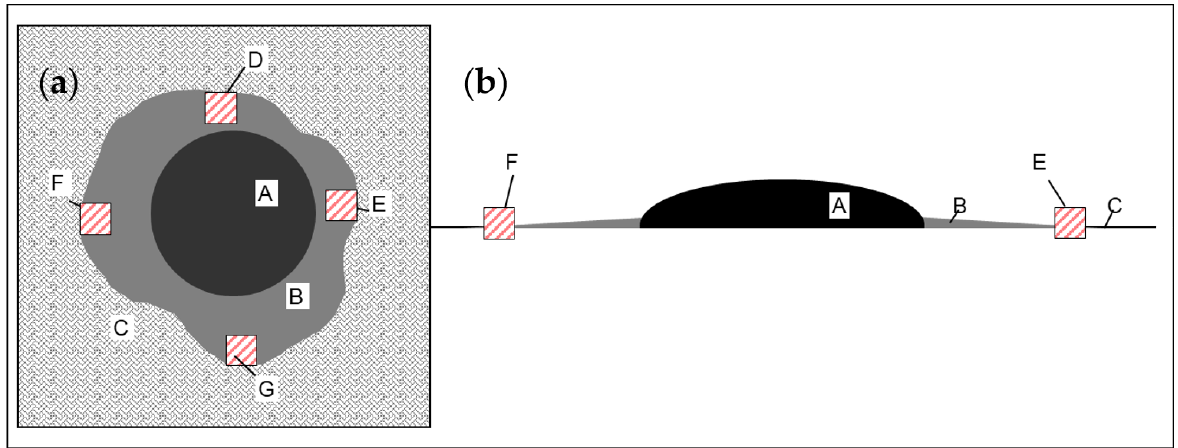
Figure 1. Schematic figure of a tumor and dural tail resection. ( a ): view from above. ( b ): view from the side. A—meningioma, B—dural tail, C—normal dura, D–F—separately resected dural specimens for histological analysis.